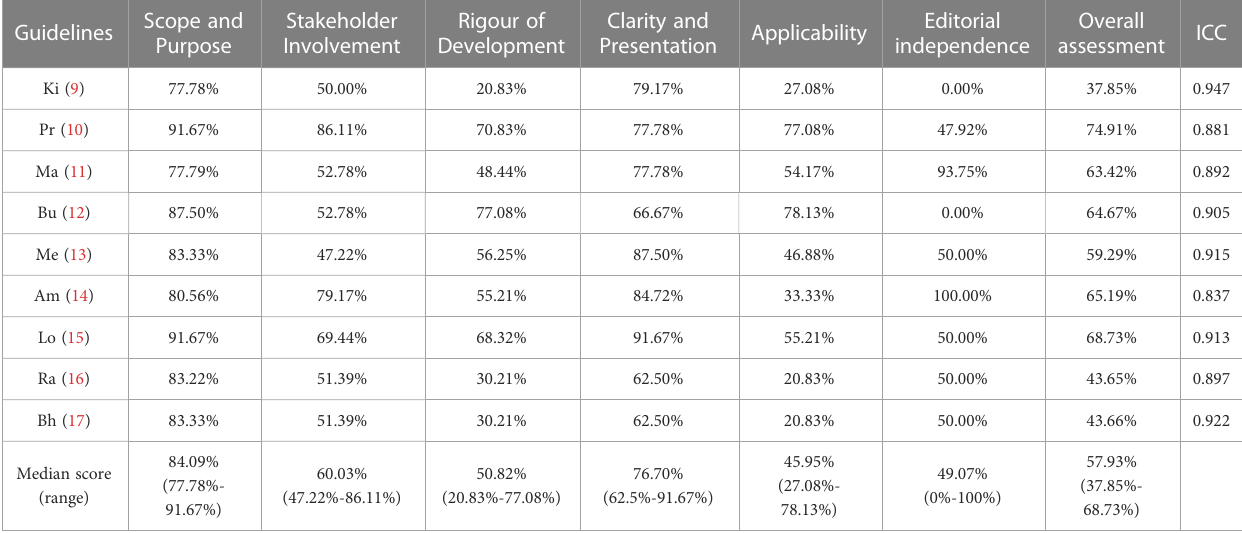
TABLE 2 AGREE II domain score and ICC of the included